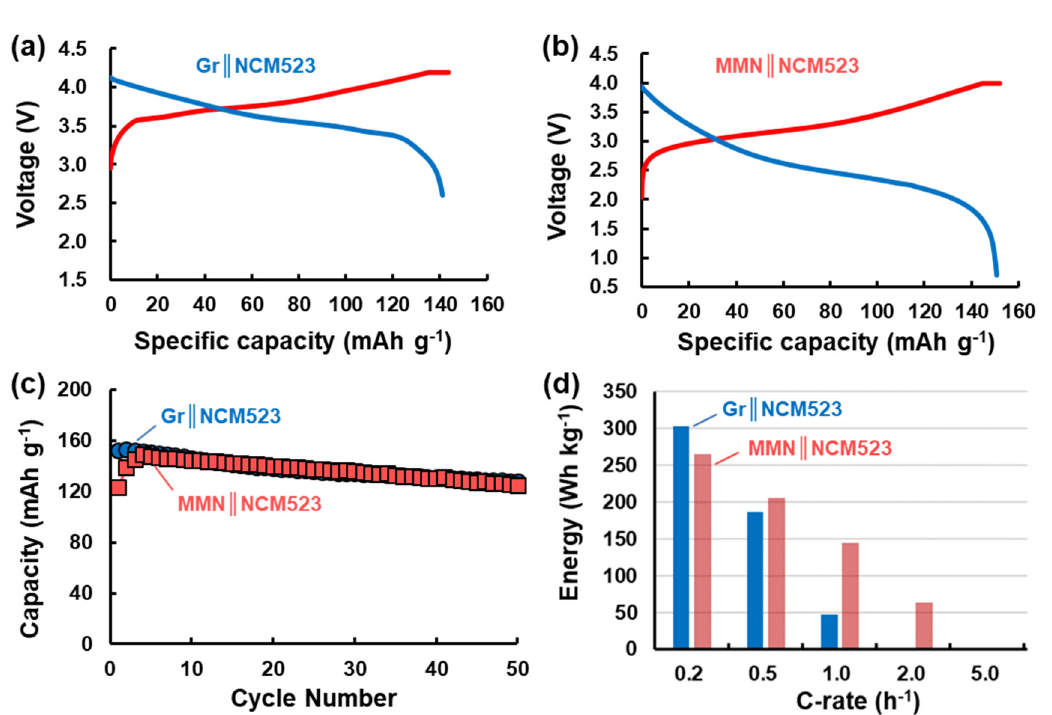
Figure 6. Reversible charge and discharge voltage profiles of ( a ) Gr ║ NCM523 and ( b ) MMN ║ NCM523 full cells at 0.2C, ( c ) cycling performances of Gr ║ NCM523 and MMN ║ NCM523 full cells at 0.2C, and ( d ) specific energy density of Gr ║ NCM523 and MMN ║ NCM523 full cells as a function of C-rate.